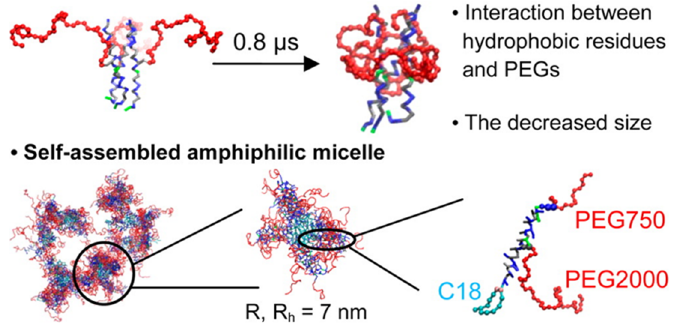
Figure 4. Initial and final snapshots of PEGylated trimeric coiled coils, showing the compact conformation of PEG due to the hydrophobic interaction (top). Snapshots of self-assembled micelles having a hydrodynamic radius of 7 nm for each micelle (bottom) (reprinted with permission from [120]. Copyright (2014) American Chemical Society).